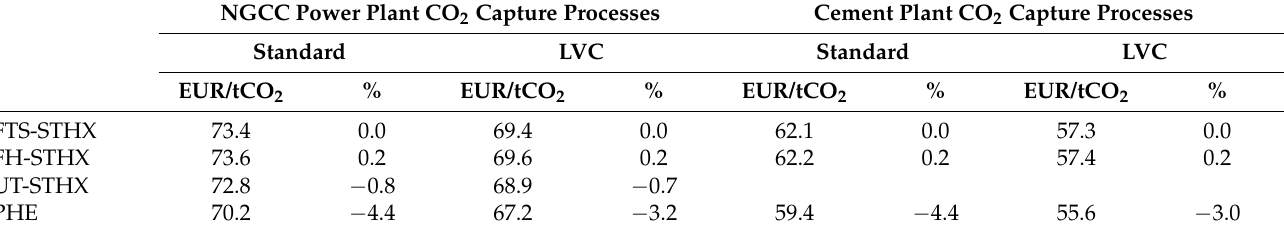
Table 15. Comparison of the base cases’ CO 2 capture cost of the different plant scenarios (reference: